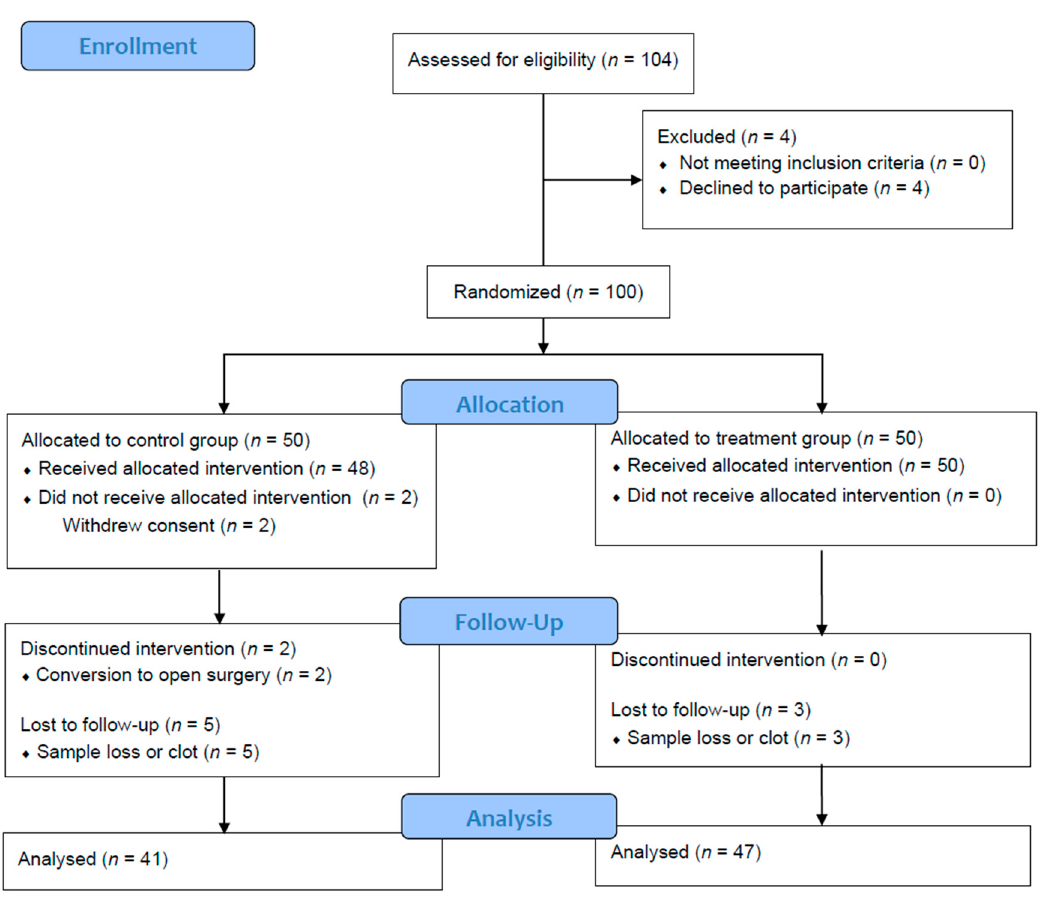
Figure 1. CONSORT flow diagram. CONSORT, Consolidated Standards of Reporting Trials.